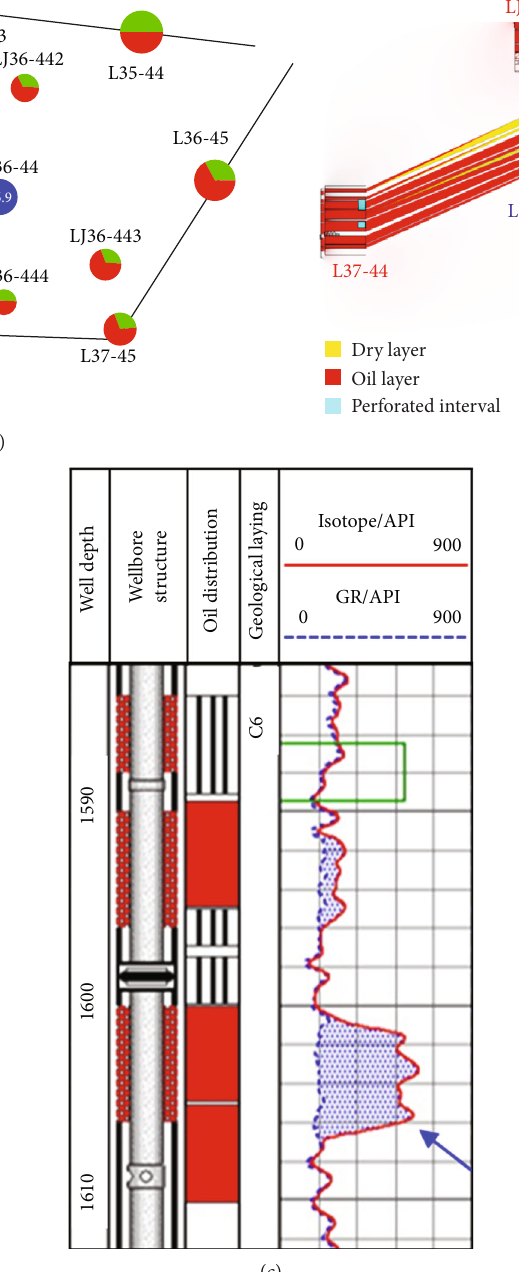
Figure 10: Performance of the well group L36-44. (a) Pie chart of production status. (b) Fence diagram of well pattern. (c) Water absorption pro fi le of